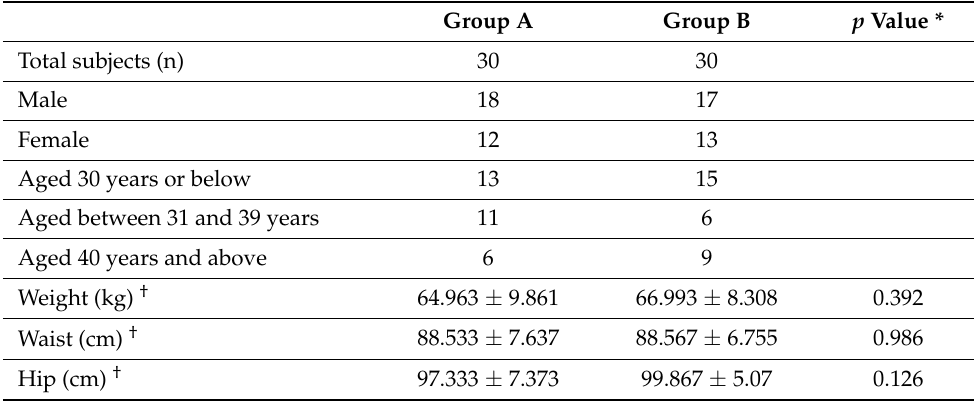
Table 1. Baseline characteristics of both